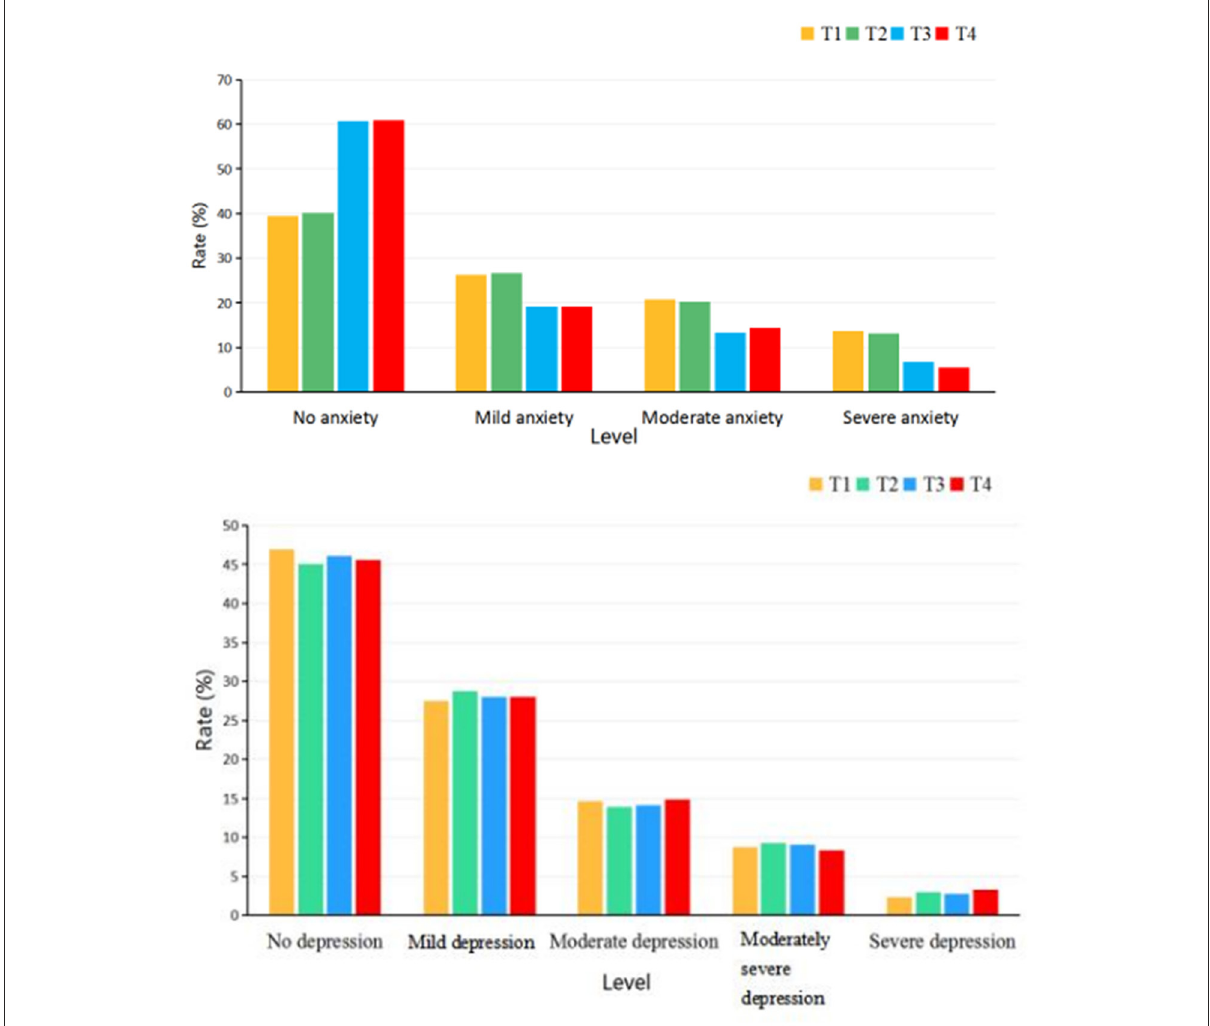
FIGURE4 The rates of different degrees of anxiety and depression symptoms among different time points. The paired comparisons of the rates of no anxiety: T1 vs.T2 showed no significant difference ( χ 2 = 0.021, df = 1, p = 0.942); T3 vs.T4 showed no significant difference ( χ 2 = 0.005, df = 1, p = 1.000); T3 is higher than T1 and T2 significantly ( χ 2 = 37.547; 33.876, df = 1, p < 0.0125); T4 is higher than T1 and T2 significantly ( χ 2 = 36.399; 34.709, df = 1, p < 0.0125). The paired comparisons of the rates of mild anxiety: T1 vs.T2 showed no significant difference ( χ 2 = 0.026, df = 1, p = 0.936); T3/T4 showed no significant difference compared with T1 and T2 ( χ 2 = 5.632; 6.416, df = 1, p = 0.022; 0.014). The paired comparisons of the rates of moderate anxiety: T1 vs.T2 showed no significant difference ( χ 2 = 0.031, df = 1, p = 0.930); T3 vs.T4 showed no significant difference ( χ 2 = 0.169, df = 1, p = 0.758); T3 is lower than T1 significantly ( χ 2 = 7.506, df = 1, p = 0.008); T3 vs.T2 showed no significant difference ( χ 2 = 6.584, df = 1, p = 0.013); T4 showed no significant difference compared with T1 and T2 ( χ 2 = 4.666; 5.651, df = 1, p = 0.039; 0.025). The paired comparisons of the rates of severe anxiety: T1 vs.T2 showed no significant difference ( χ 2 = 0.044, df = 1, p = 0.917); T3 vs.T4 showed no significant difference ( χ 2 = 0.544, df = 1, p = 0.556); T3 is lower than T1 and T2 significantly ( χ 2 = 10.022; 8.786, df = 1, p =